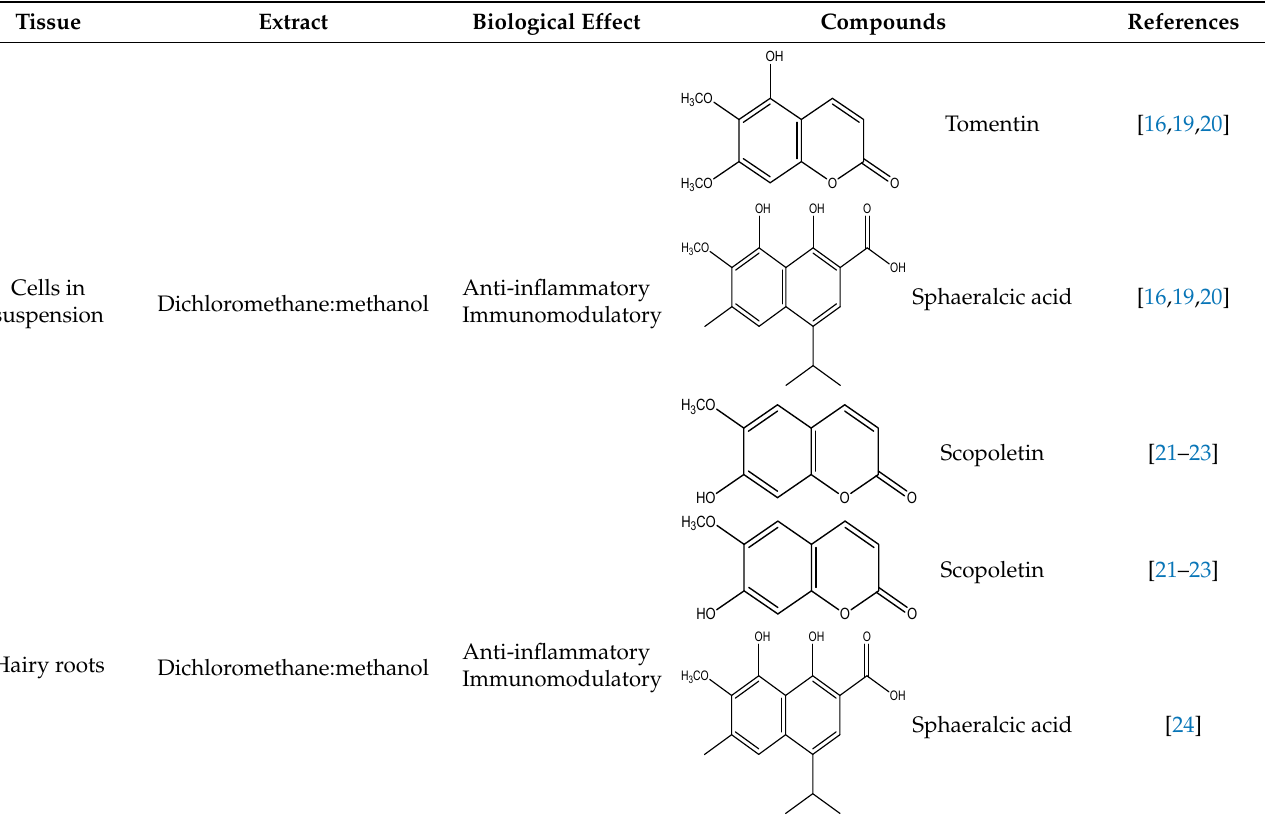
Table 2. Chemical structures of compounds identified in the Sphaeralcea angustifolia in vitro cultures.